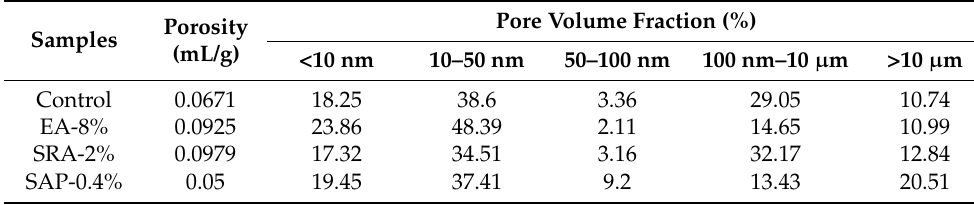
Table 4. Pore volume and porosity of hardened mortars